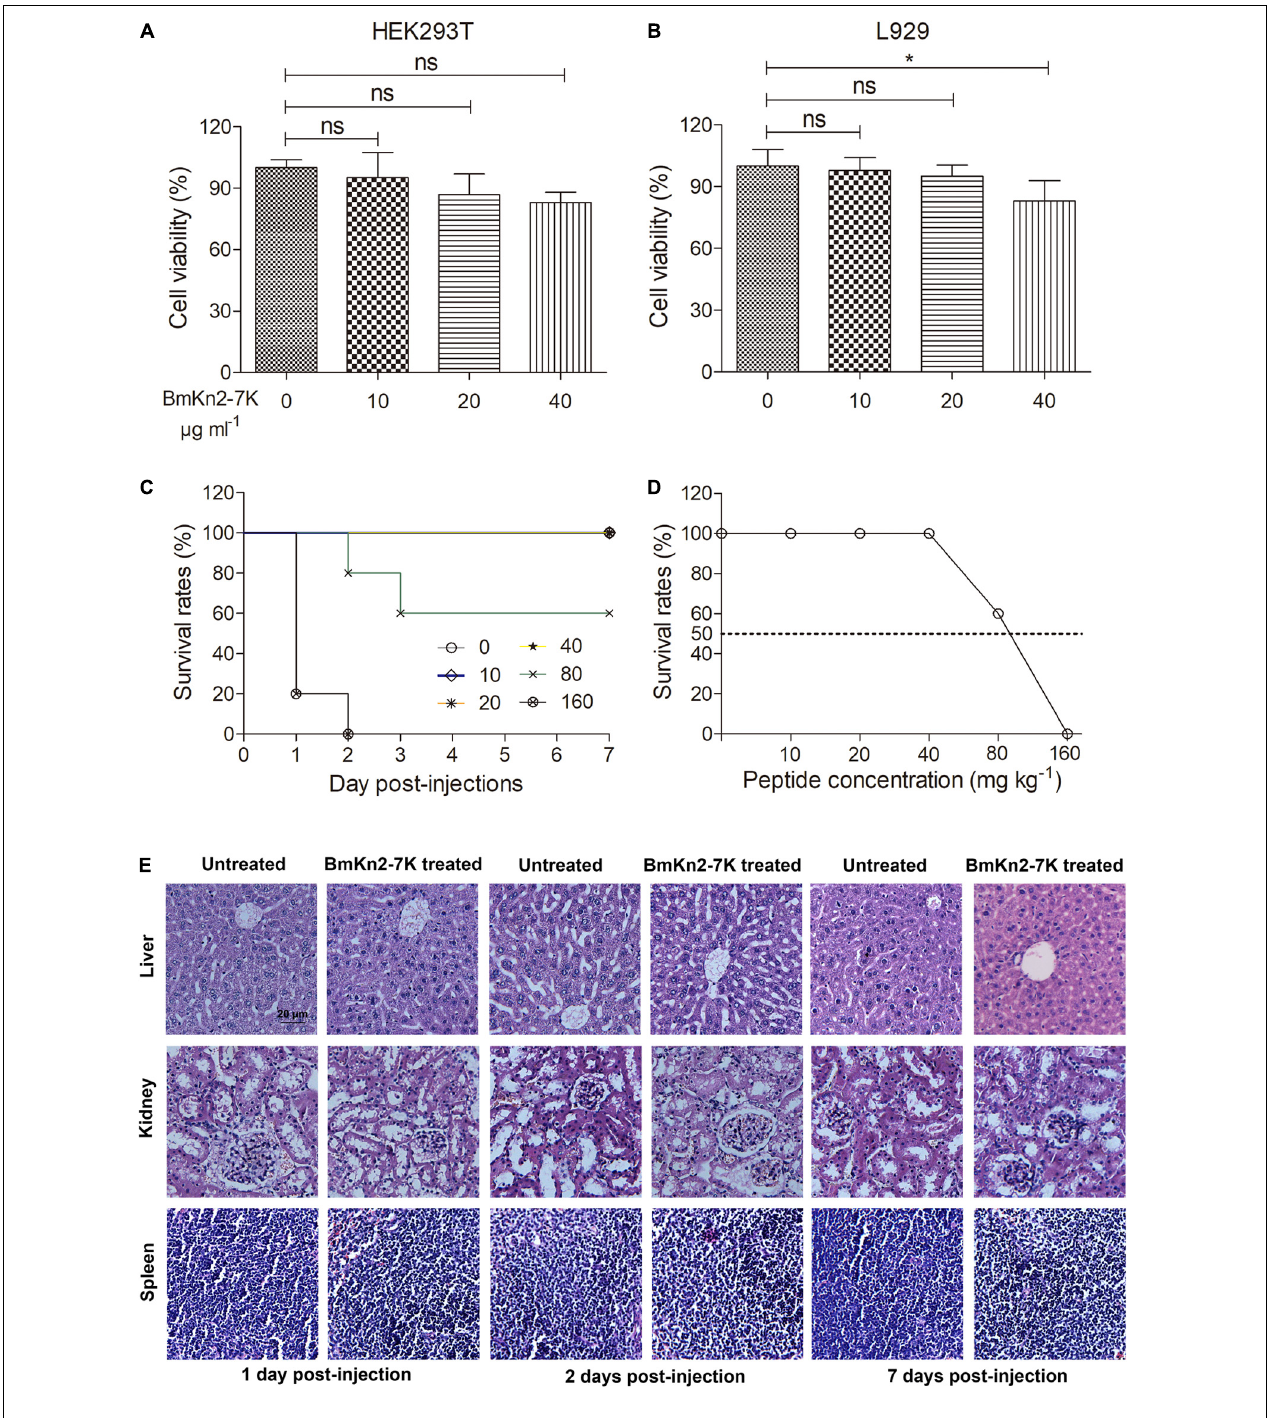
FIGURE 5 | Safety profile of BmKn2-7K. (A,B) The cytotoxicities of the peptide were determined against HEK293T and L929. The data represent average ± standard error of three independent experiments. * P < 0.05; ns. represents “no significance.” The statistical significance between the groups was analyzed using one-way ANOVA followed by Tukey’s post hoc test to correct for multiple comparisons. (C) Kaplan-Meier plot for the survival of ICR mice treated with BmKn2-7K. (D) The survival rates of mice after treating with different doses of BmKn2-7K. Each cohort of ICR mice ( n = 10) was injected intraperitoneally with a single dose of BmKn2-7K at concentrations ranging from 10 to 160 mg kg − 1 body weight, followed by survival inspection for 7 days. Mice without peptide injection were set as the normal control. (E) Histopathological examination of ICR mouse liver, kidney and spleen sections. Each cohort of mice ( n = 6) were injected intraperitoneally with a single dose of 40 mg kg − 1 mouse body weight BmKn2-7K, and the mice were euthanized at 1, 2, and 7 days after treatment and stained with haematoxylin-eosin for observation. Mice without peptide injection were set as the normal control. The bar represents 20 µ m.